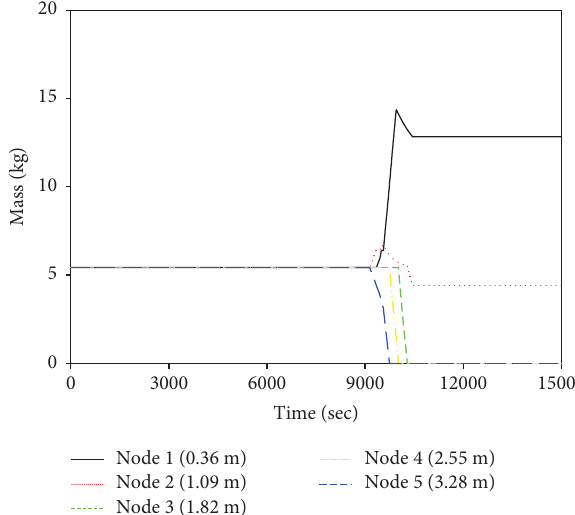
Figure 11: CINEMA results on fuel mass in TMI-2 severe